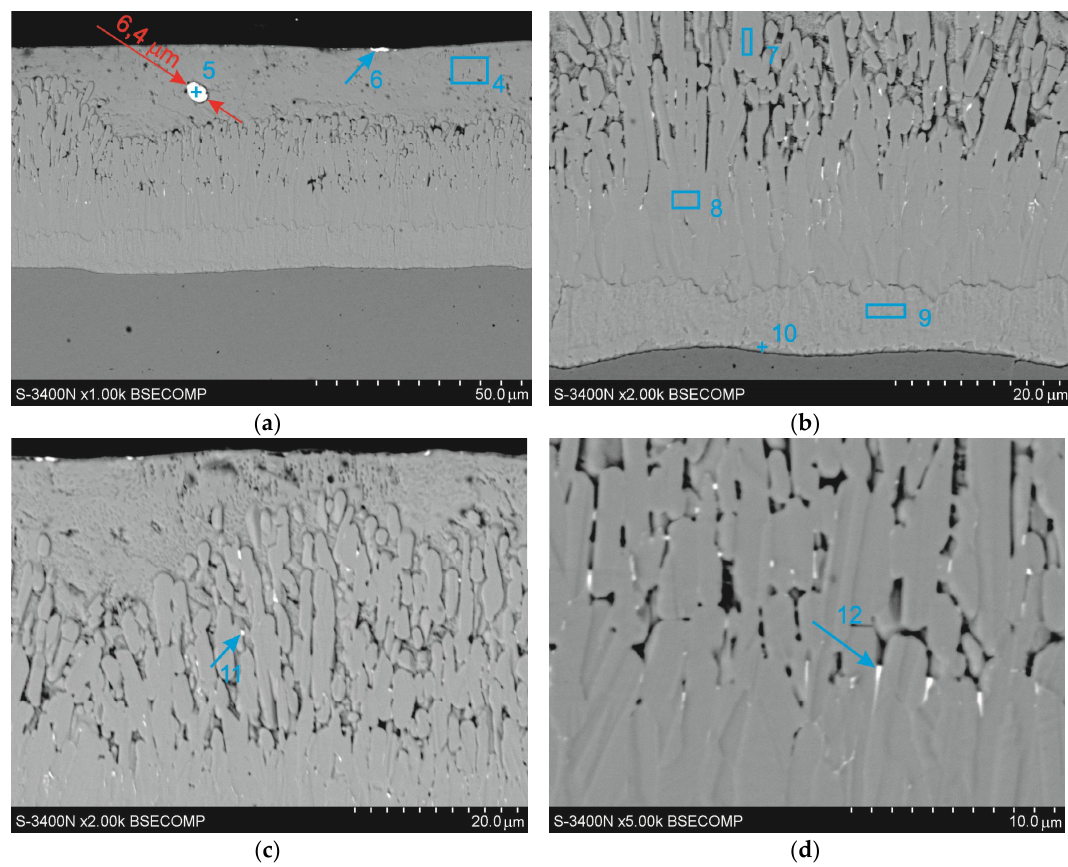
Figure 5. Microstructure (SEM) of the Zn–AlNiBi coating cross-section: ( a ) sight of the cross-section of the coating with large precipitation in the outer layer; ( b ) view of the diffusion layer of the coating; ( c ) bismuth precipitation on ζ phase crystals in a zone of heterogeneous structure; ( d ) bismuth precipitation in the ζ phase of the compact structure.